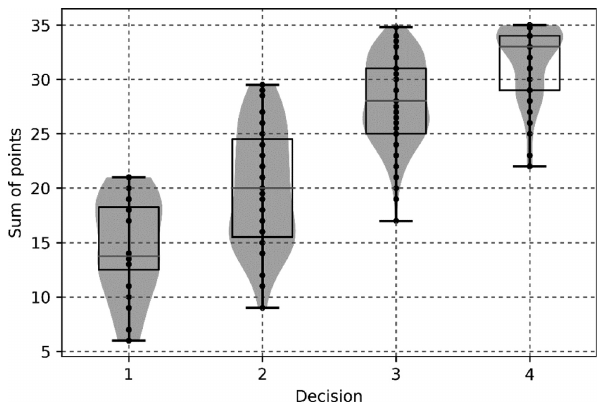
Fig. 1: Relation between total number of points and the